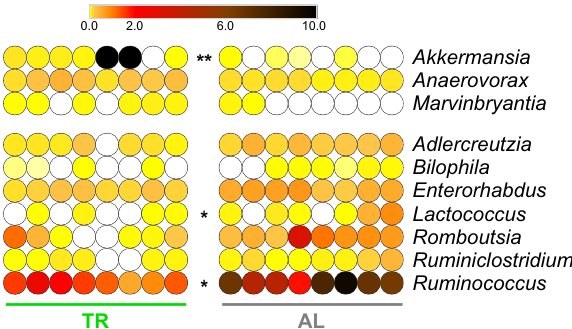
Fig. 2 Changes in taxonomic genus composition in the fecal microbiota of TR- vs. AL-fed rats according to 16S rRNA gene sequencing results. Heatmap illustrating genera with signi fi cantly differential abundance between AL and TR groups (FDR < 0.1). A single or double asterisk refers to FDR < 0.01 or <0.001, respectively. Each dot indicates a different sample. The color gradient is based on the relative abundance of the